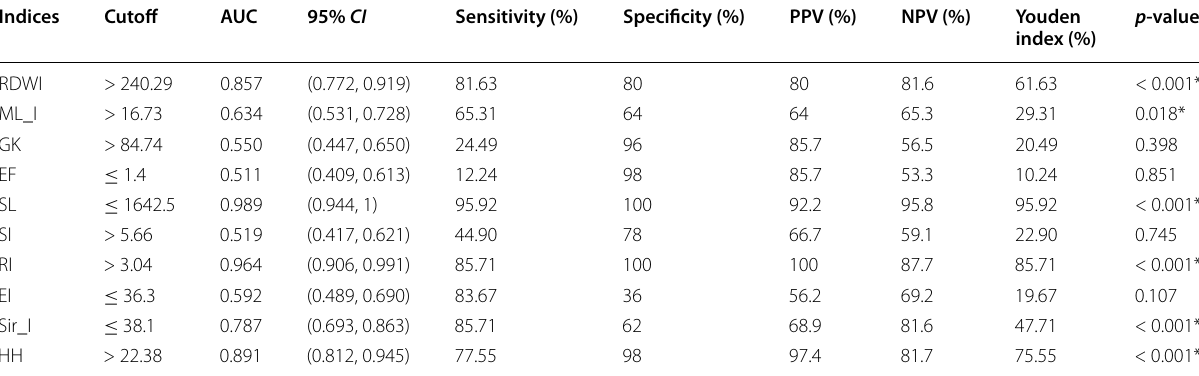
Table 6 The curve of receiver operating characteristic (ROC) of the studied indices for optimum cutoff points in diagnosing iron deficiency anemia (compared to healthy